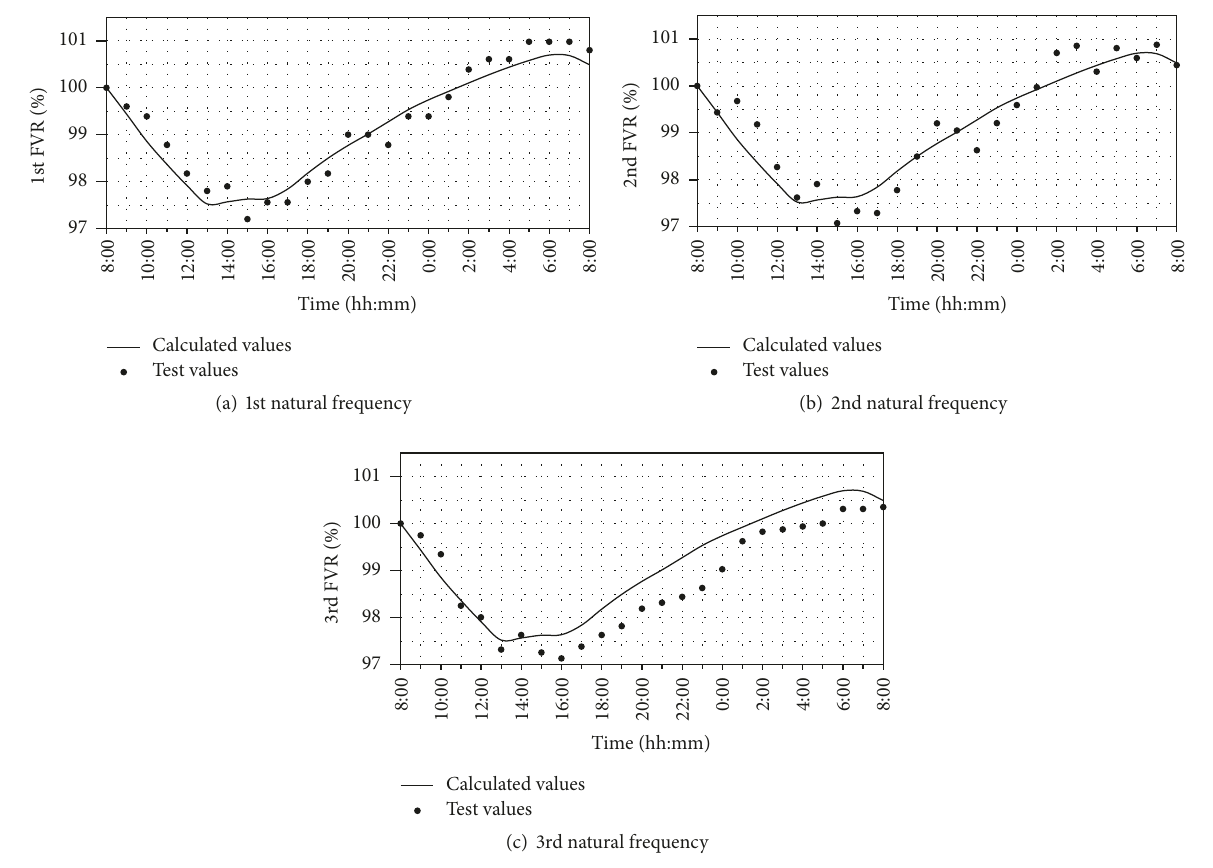
Figure 15: Comparison of FVR between test and calculation results at different times.